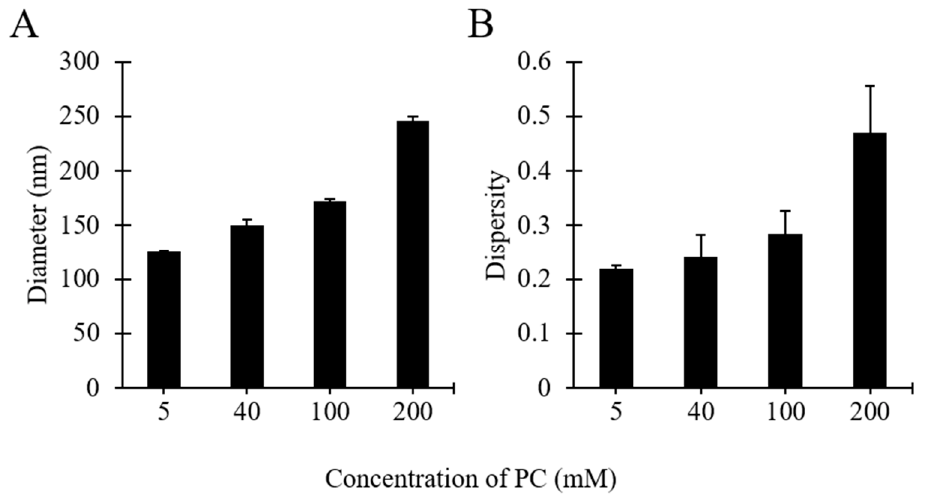
Figure 6. Effects of lipid concentration on liposome size ( A ) and dispersity ( B ). Data represent the means of three measurements with corresponding standard deviations. Refer to Table 1 (batch codes #17 PC, #16 PC, #1 PC, #15 PC) for the corresponding experimental conditions, lipid compositions, and numerical data of mean values and standard deviations.